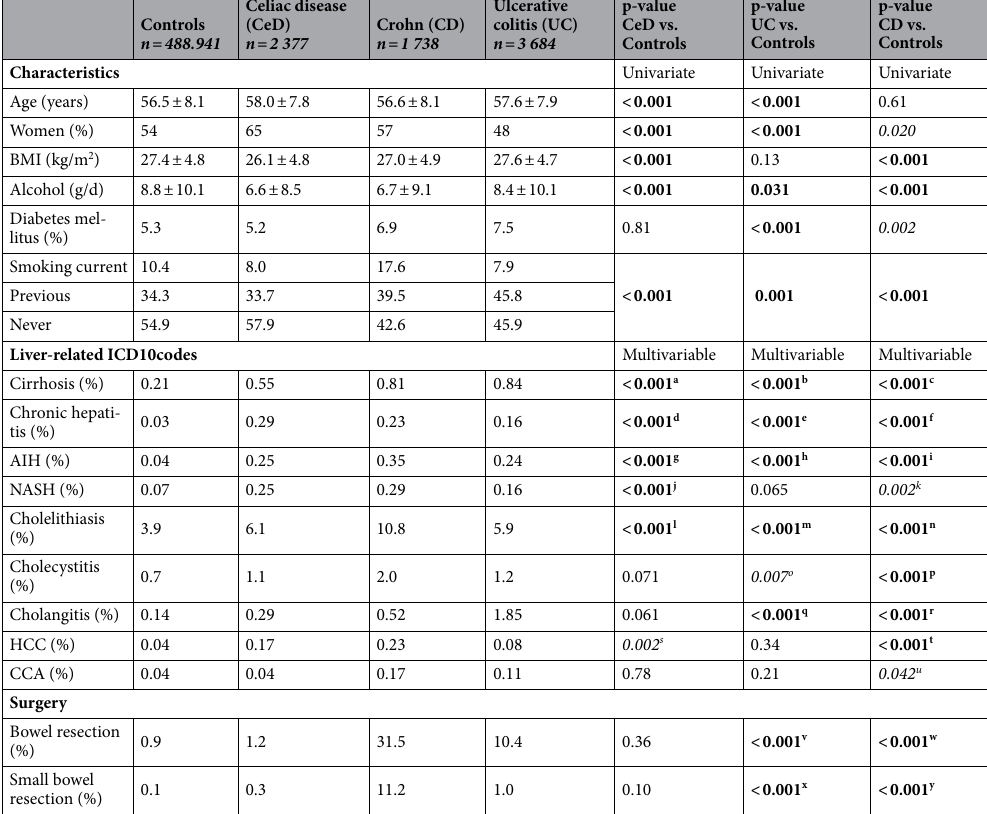
Table 1. Liver phenotype in UK Biobank cohorts with celiac disease, Crohn’s disease or ulcerative colitis compared to controls. Quantitative measures are expressed as mean with standard deviation or relative frequency (%). Multivariable analyses were adjusted for age, sex, BMI, presence of diabetes mellitus, and mean alcohol consumption. p-values 0.001–0.05 in italics and p-value < 0.001 in bold. BMI body mass index, CCA cholangiocarcinoma, NASH Non-alcoholic steatohepatitis. a aOR = 3.59[2.11–6.10]; b aOR =